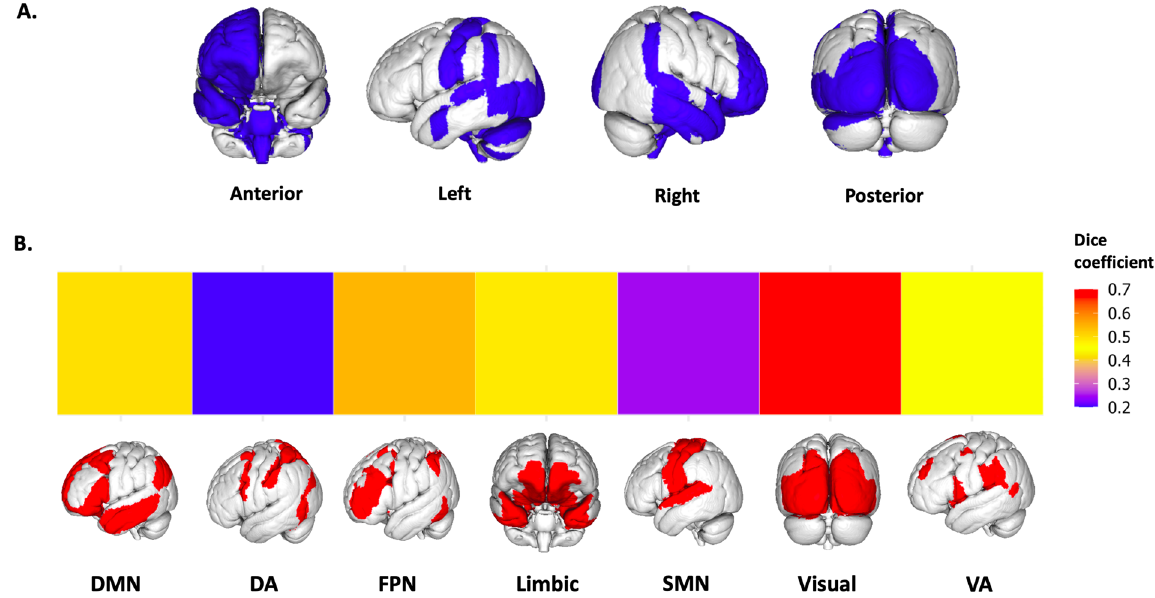
Fig. 6 Overlap between the neural circuits engaged by exogenous oxytocin at rest and the canonical large-scale resting-state networfks. We calculated the percentage of overlap between our single binary map including all regions showing alterations in regional functional connectivity after oxytocin (irrespective of route/method of administration) and the large-scale resting-state networks described in the atlas from Yeo et al. (2011) 105 . Overlap was quanti fi ed using the Dice coef fi cient, which measures the percentage of voxels of each resting-state network overlapping with our treatment effect mask. In the upper panel A, we provide an overview of all regions where we found treatment effects, irrespective of route/method of administration, rendered in a 3D surface model. In the lower panel B, we provide a heatmap summarizing the percentage of overlap (Dice coef fi cient) between the regions in A and each of the seven networks (each network rendered in a 3D surface model). DMN Default-mode network, DA Dorsal attention, FPN Frontoparietal network, SMN Sensorimotor network, VA Ventral